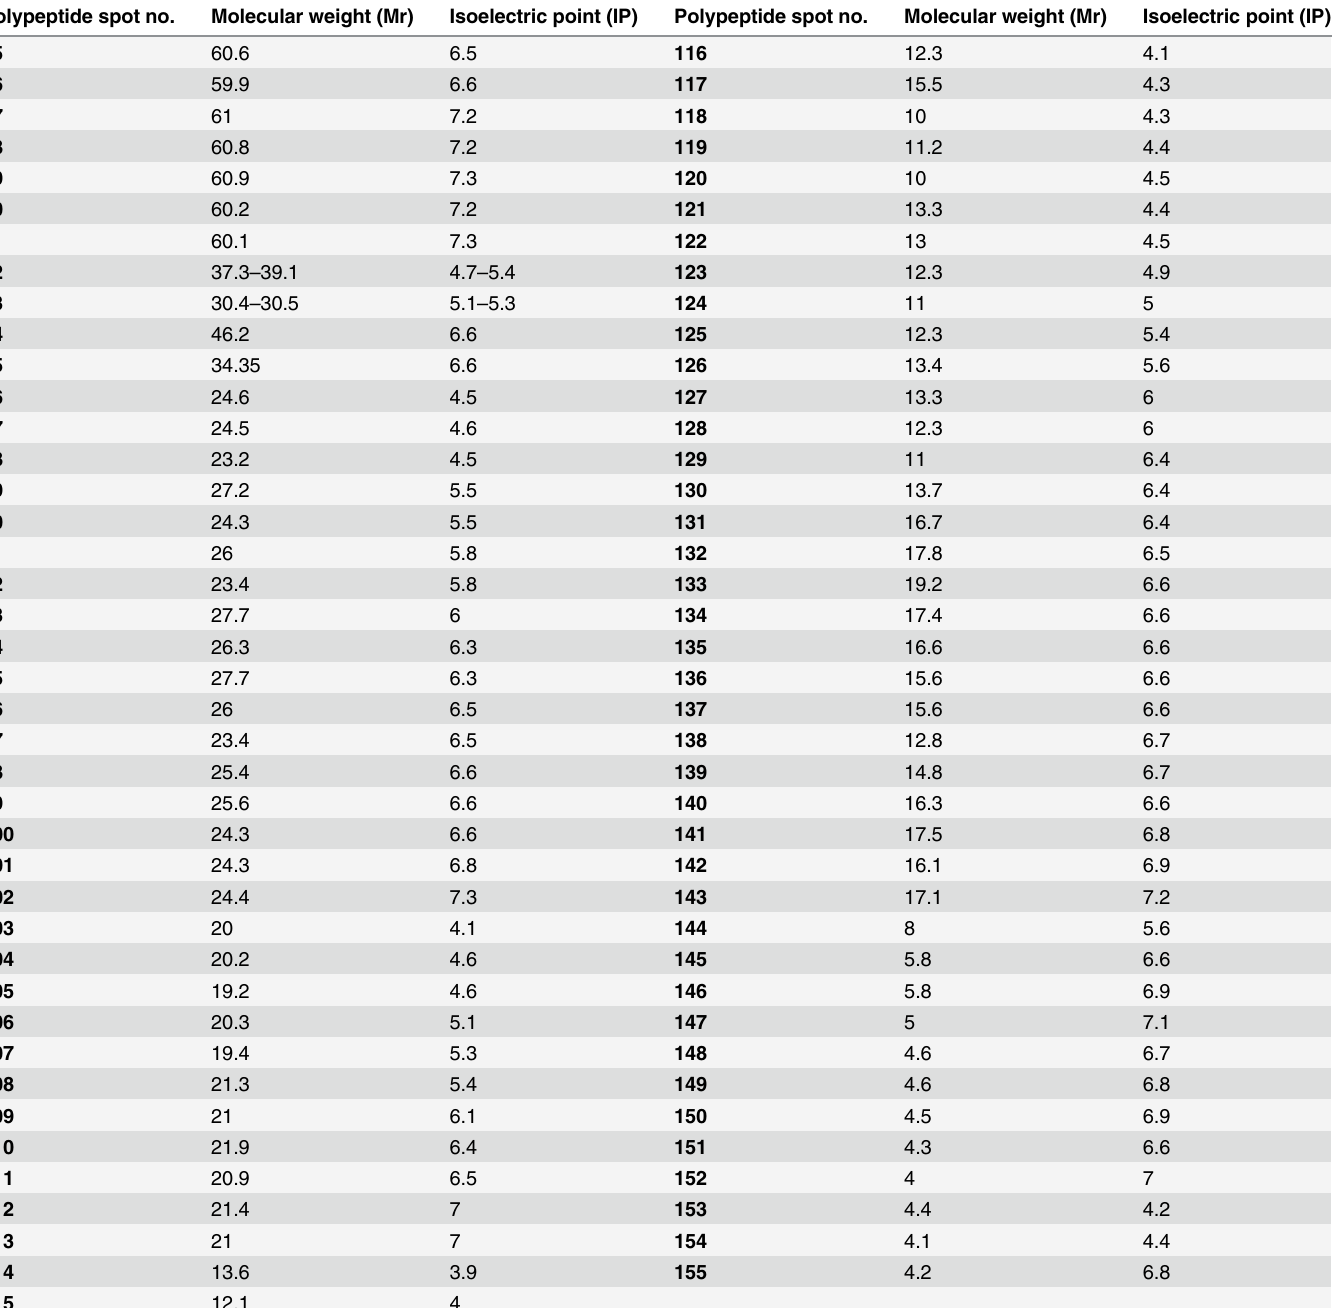
Table 1. T . gondii strain RH tachyzoite proteins (Fig.